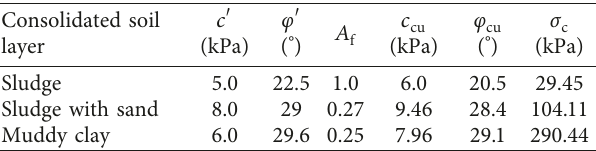
Table 2: Initial consolidation pressure and initial shear strength index of the soil layers.